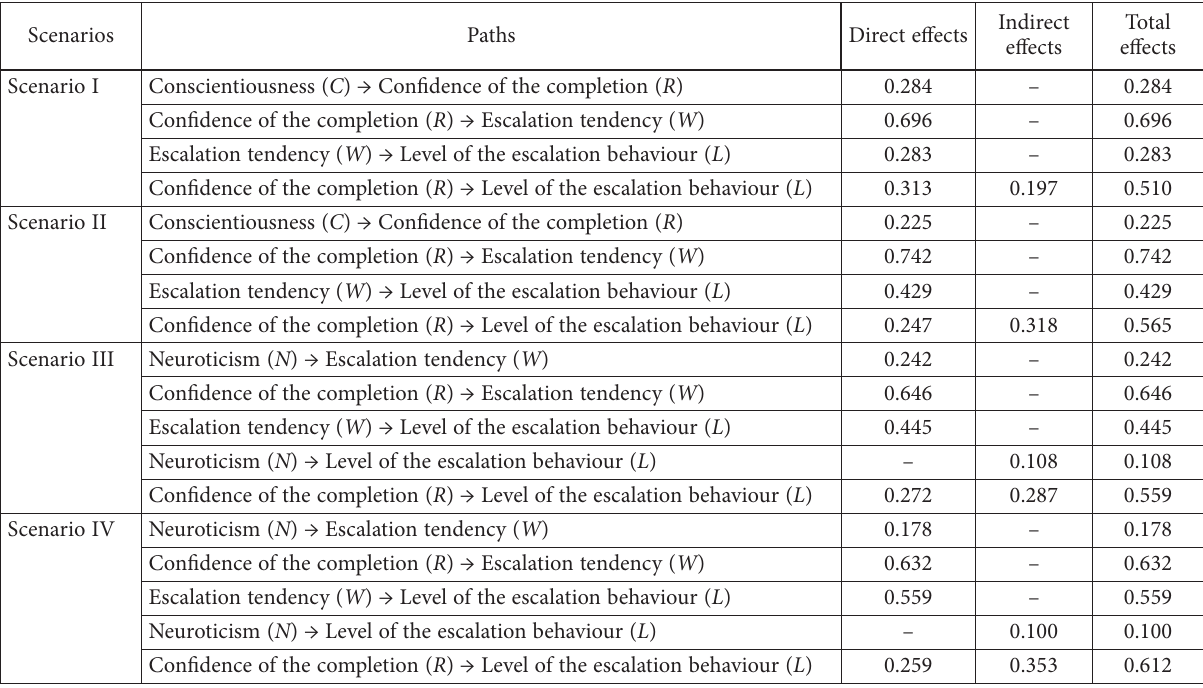
Table 7. Path effects of investors’ EOC in PPPs